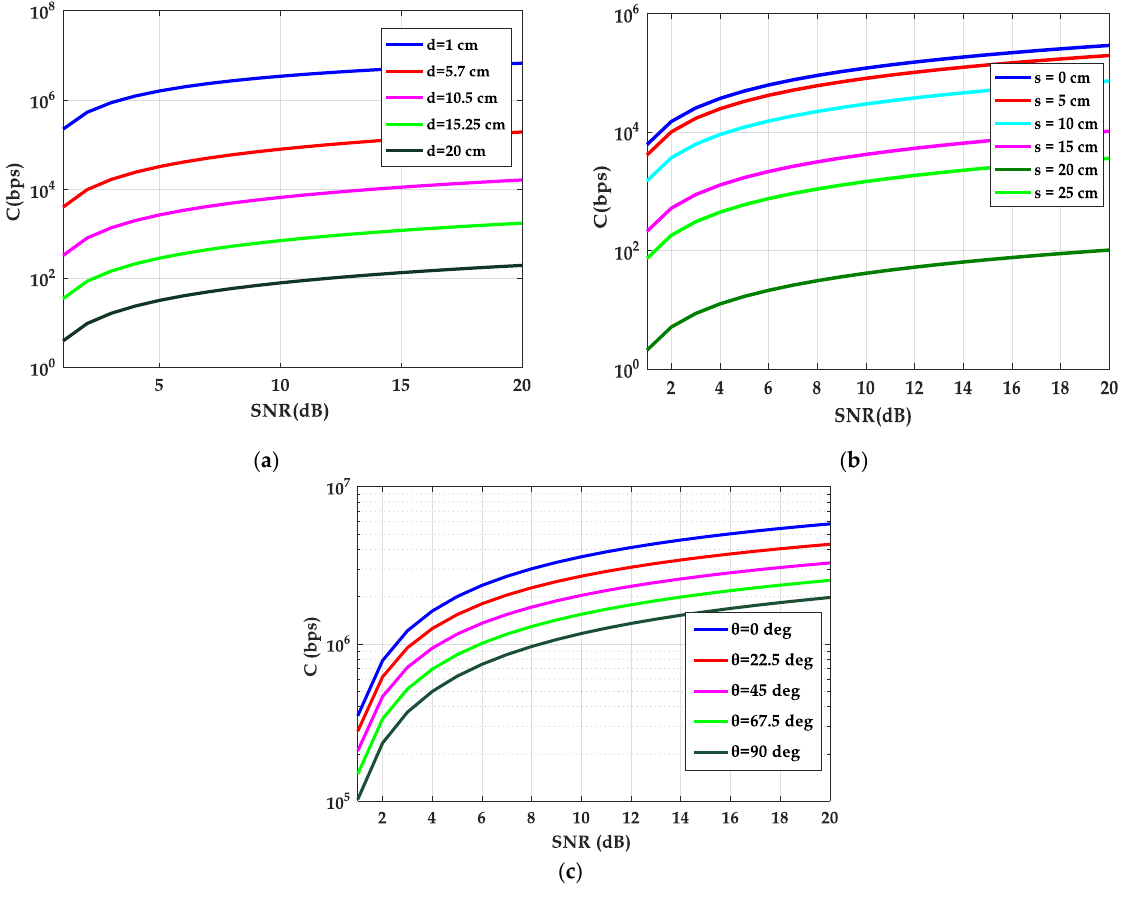
Figure 10. Simulation results of channel capacity for R s = R L = 50 Ω ; ( a ) distance d between the transceivers; ( b ) lateral displacement of the RX coil for d = 5 cm; ( c ) angle deviation θ.